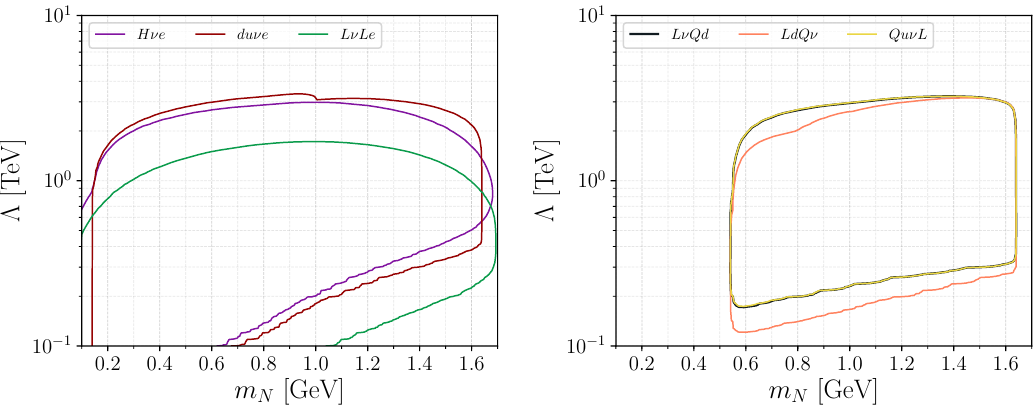
Figure 8 . Sensitivity limits for the various EFT scenarios. We fix the Wilson coefficients at 1 and show projected bounds on the new-physics scale, Λ , as functions of m